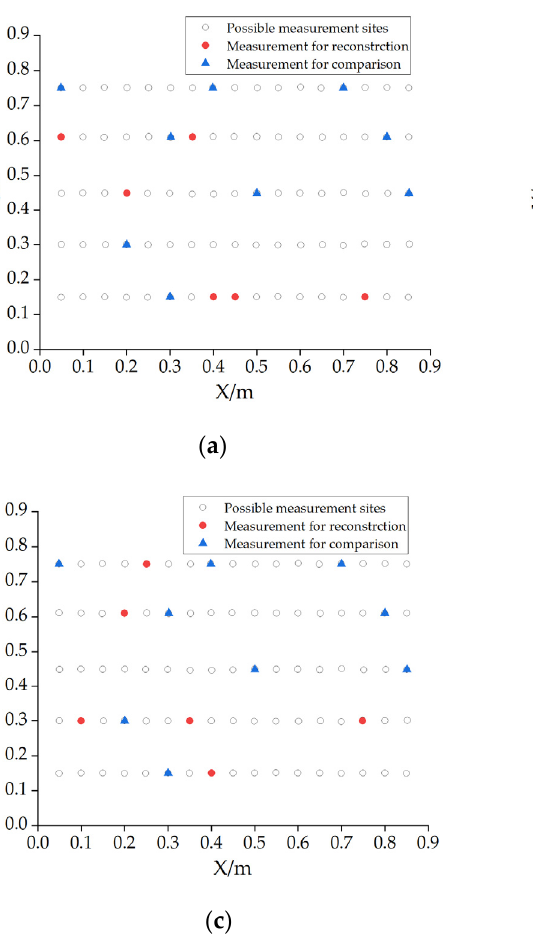
Table 6. Temperature values (K) for test reconstruction result.